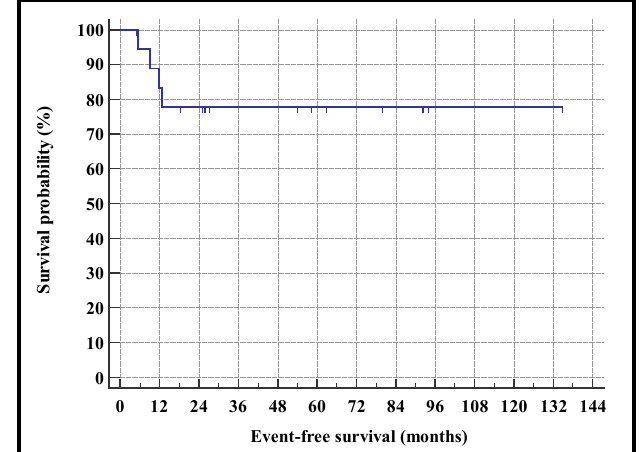
Figure 3: Kaplan-Meier curve of event-free survival of 19 children with vaginal